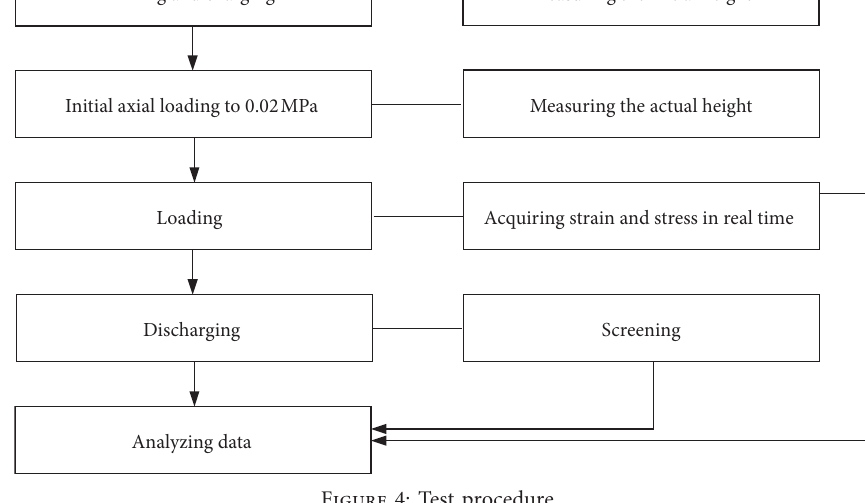
Figure 4: Test procedure.